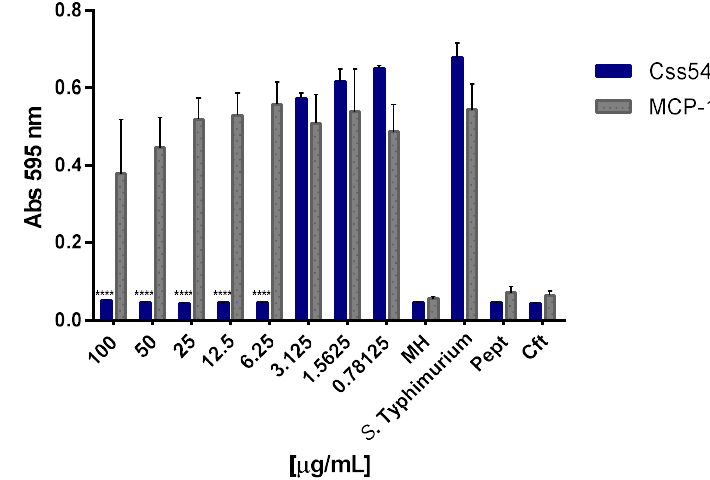
Figure 1. Css54 inhibits the growth of Salmonella Typhimurium. Different concentrations of Css54 and MCP-1 were incubated with 1 × 10 8 cells of S. Typhimurium ATCC 14028 in Mueller–Hinton (MH) broth ( n = 3). MH: broth without bacteria; S . Typhimurium: Bacteria without treatment; Pept: Css54 or MCP-1 [0.39 µg/mL each] + MH; Cft: bacteria + ceftriaxone [100 µg/mL]. The mean is the average of three independent experiments (**** p < 0.0001) .